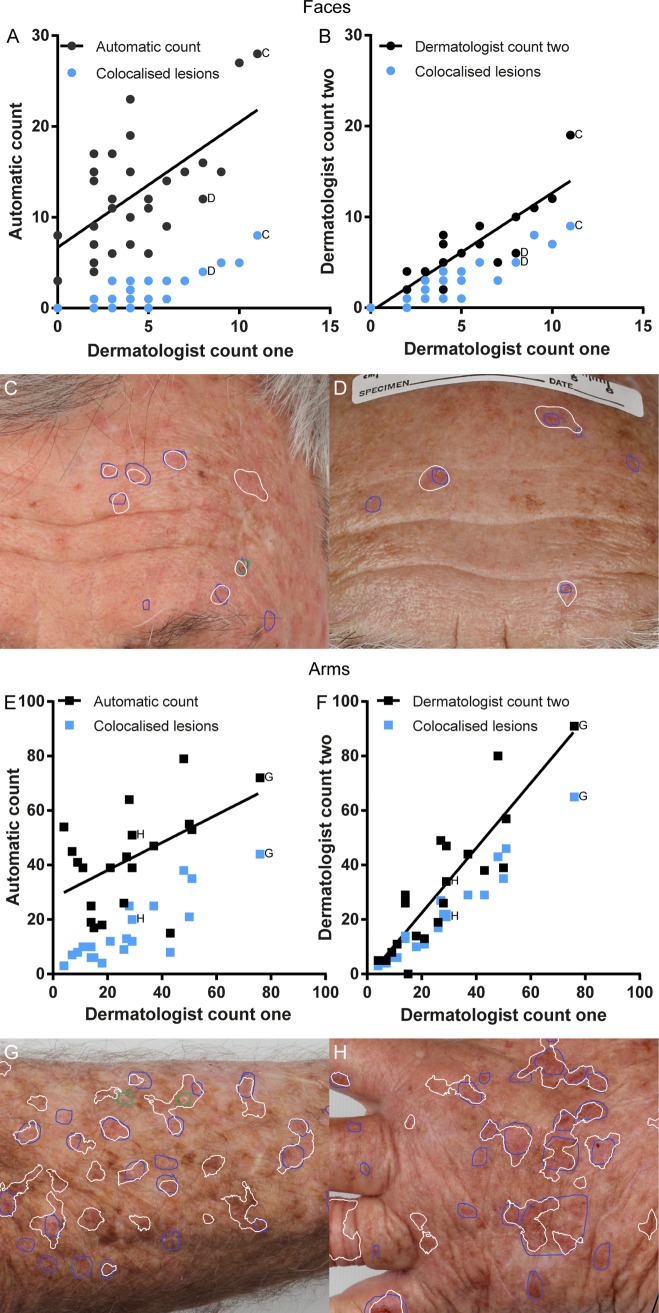
Comparison of automatically detected lesions with dermatologist circumscribed lesions for each body site.Each point represents the total count for each method from one clinical photograph in the severe photodamage group. Labelled points correspond to photographs shown. White outlines are automatically detected regions, blue/green outlines are dermatologist annotations. A) Automatically counted lesions on each face photograph compared with dermatologist count, and number of co-localized lesions. B) Dermatologist second count on faces compared with first count, and number of co-localized lesions. C-D) Example of automated output compared with dermatologist on two foreheads. E) Automatically counted lesions on each arm photograph compared with dermatologist count, and number of co-localized lesions. F) Dermatologist second count on arms compared with first count, and number of co-localized lesions. G-H) Example of automated output compared with dermatologist annotation on forearm and hand.